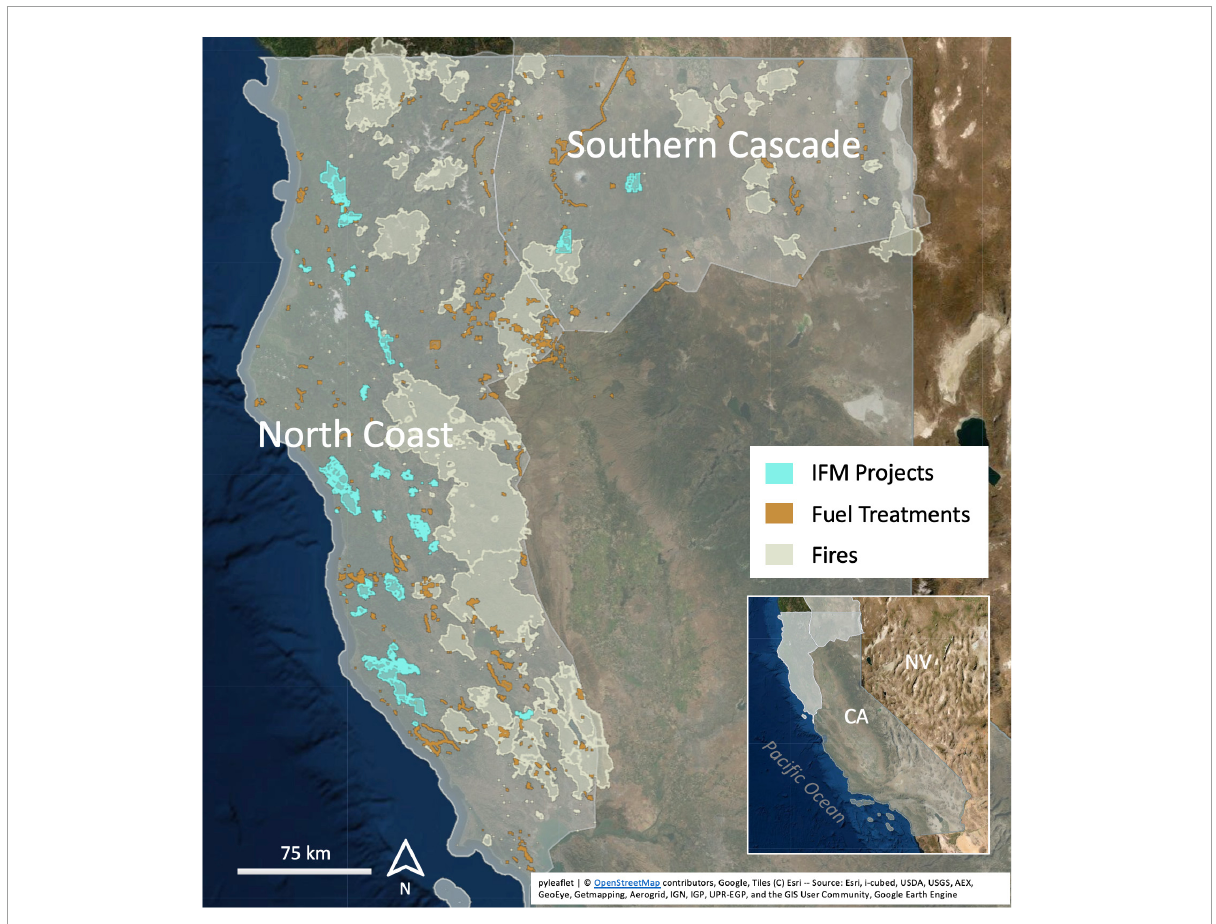
FIGURE1 Study Area Map showing the North Coast and southern Cascade region in northern California. This map includes fires between 2016-2020 and locations of IFM projects and fuel